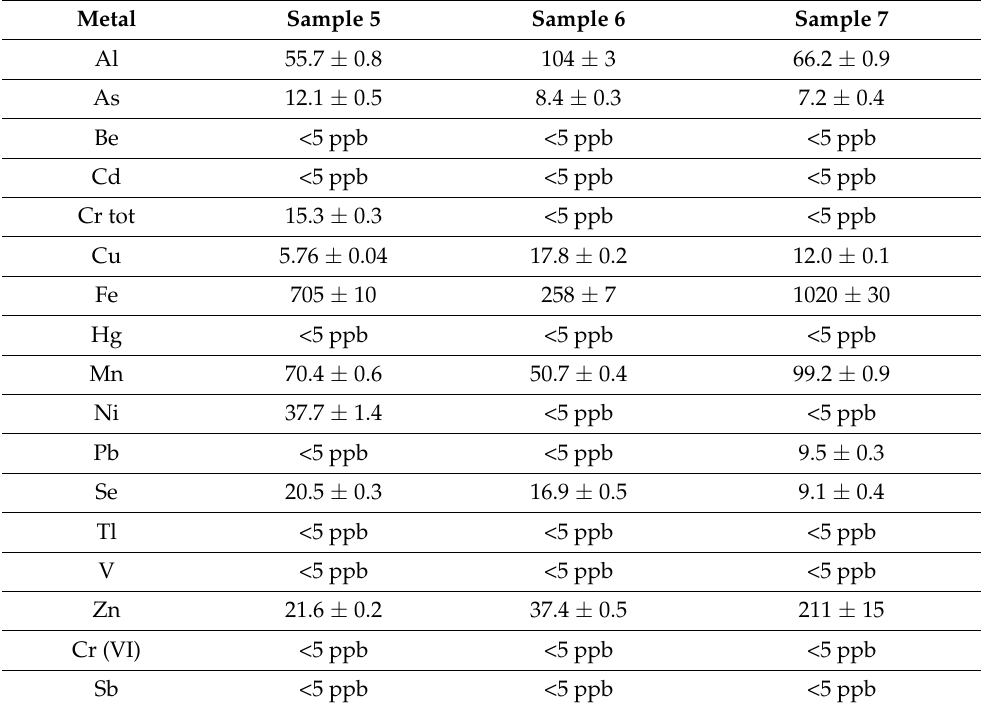
Table 3. Analysis of wine samples: Listed metal contents are means of triplicate determinations (as ppb) ±